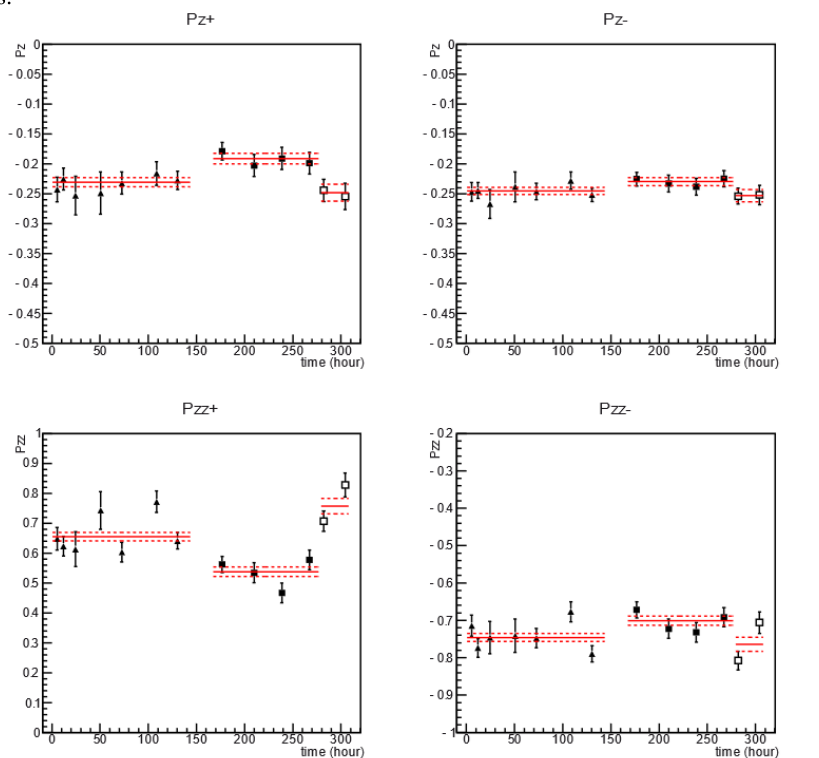
Fig. 1. Polarizations values P z and P zz for spin modes (P z , P zz )= (-1/3,-1) and (-1/3, +1) during the runs in 2016.